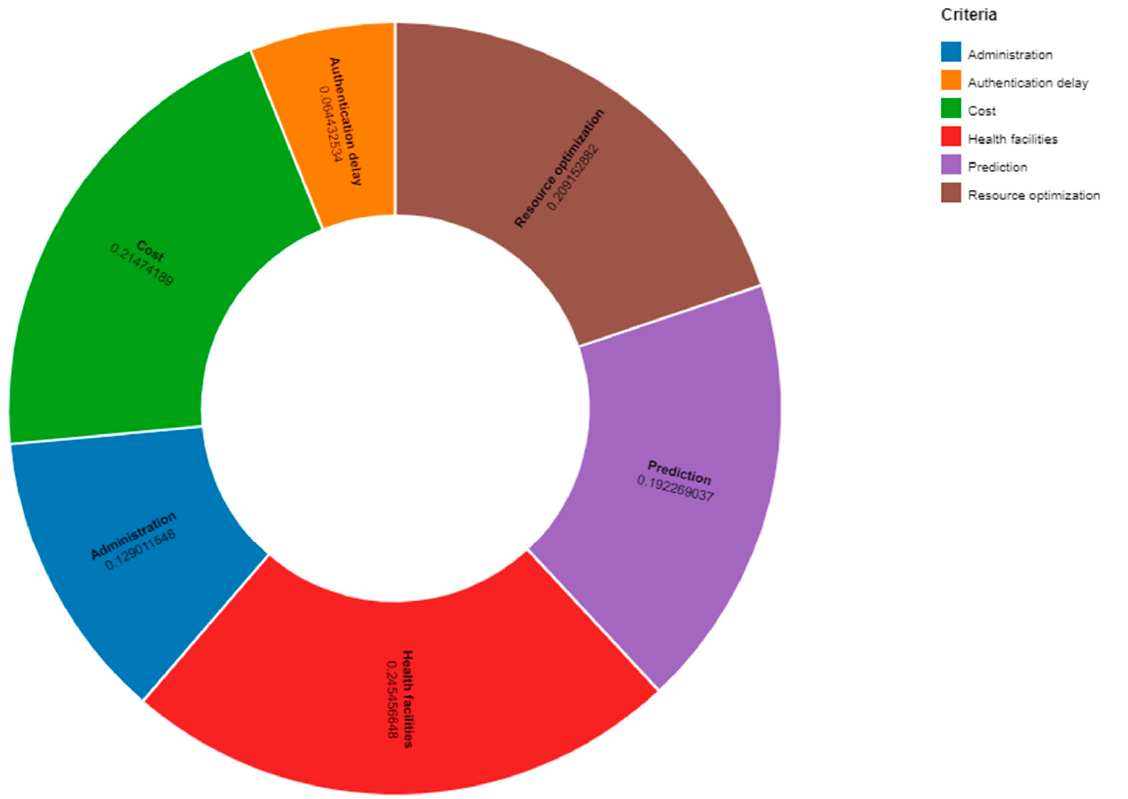
Figure 4. Calculated Weights.